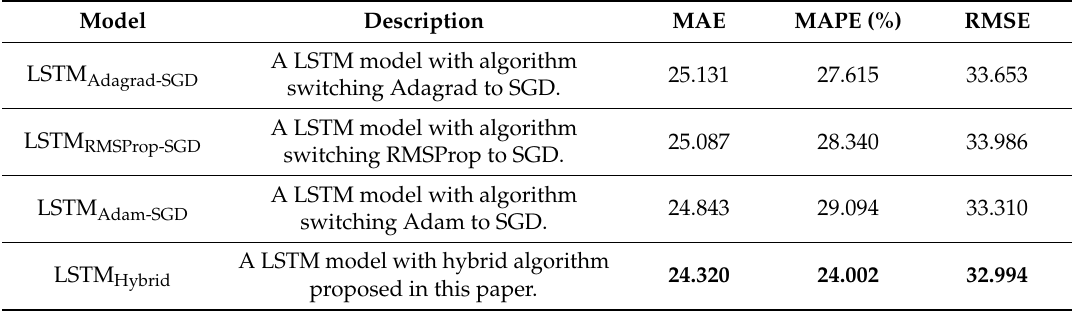
Table 5. Model comparison of using other adaptive algorithms at the first stage. Model